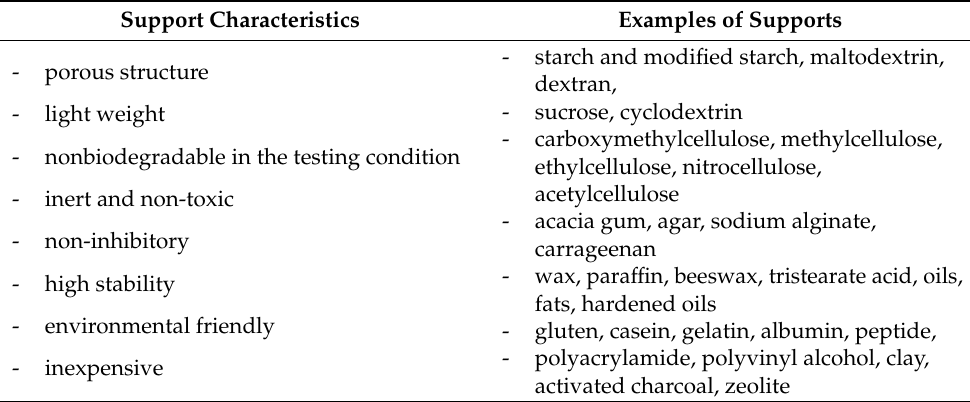
Table 2. Characteristics of a suitable biomass carrier/biosorbent support [6,22–25].